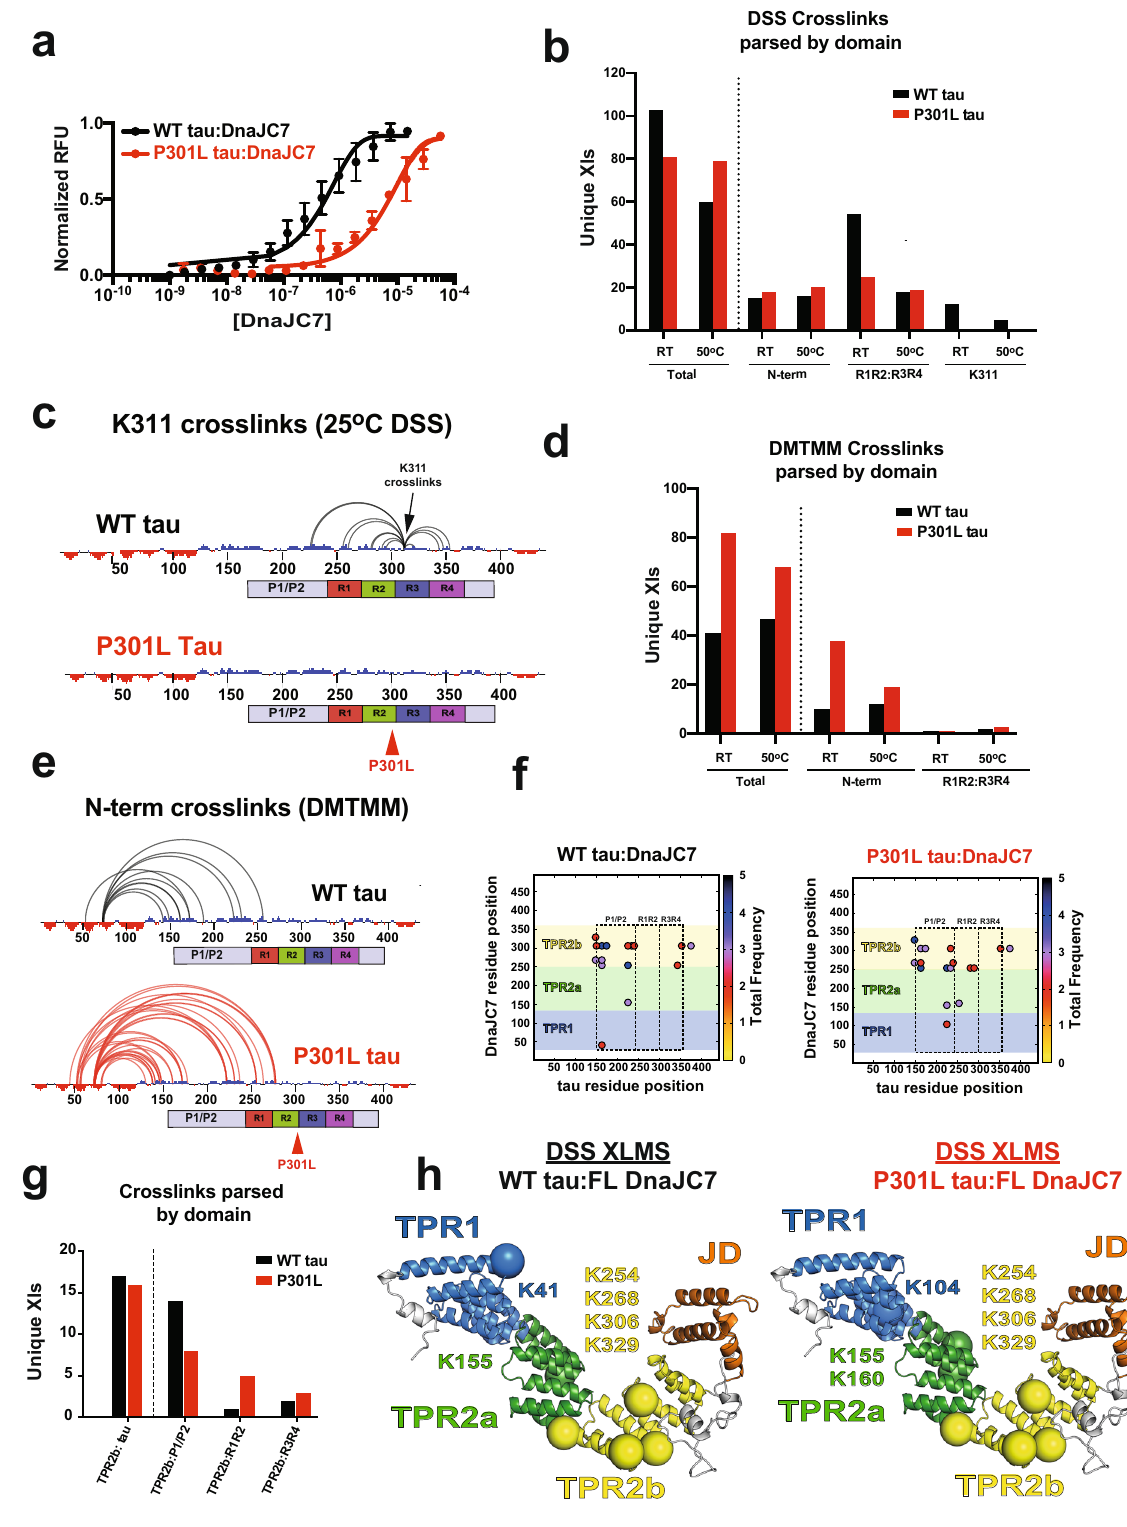
consensus cross-links at 25 °C for WT tau using the DSS and DMTMM chemistries, respectively. The reactions performed at 50 °C for WT tau yielded a nearly two-fold drop in DSS cross- links (Fig. 3b, 60 pairs), while the number of DMTMM pairs remained fl at at 47 cross-links (Fig. 3d). For P301L tau, we identi fi ed 81 and 82 consensus cross-links using the DSS and DMTMM chemistries at 25 °C, respectively. In contrast to the